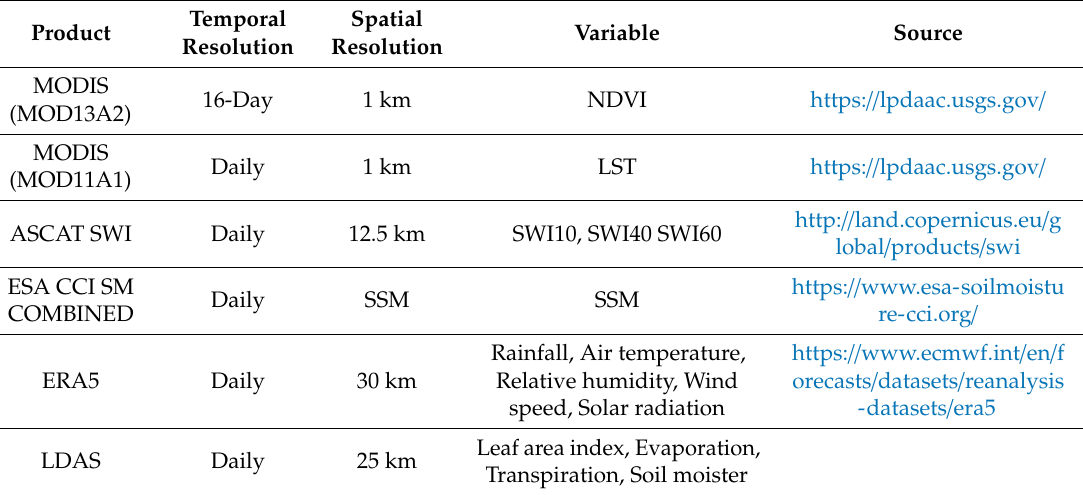
Table 3. Summary of the dataset used in this